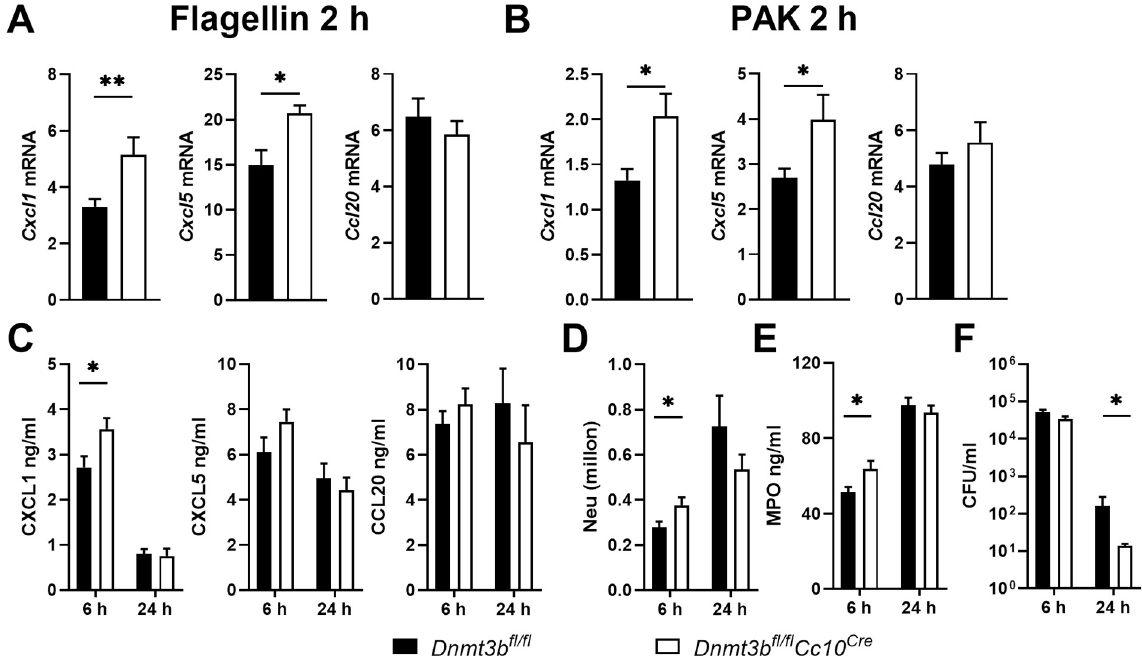
Fig 4. Bronchial epithelial deficiency of Dnmt3b promotes CXCL1 production by bronchial epithelial cells at the early phase of Pseudomonas pneumonia in vivo . Dnmt3b fl/fl Cc10 Cre and control Dnmt3b fl/fl mice received flagellin (1 μ g) purified from P . aeruginosa intranasally. Cxcl1 , Cxcl5 and Ccl20 mRNA expression in bronchial brushes collected at 2 hours (A). Dnmt3b fl/fl Cc10 Cre and control Dnmt3b fl/fl mice were infected with PAK (5 x 10 6 CFU) intranasally. Cxcl1 , Cxcl5 and Ccl20 mRNA expression in bronchial brushes collected at 2 hours (B). CXCL1, CXCL5 and CCL20 (C), neutrophil counts (D), MPO (E) and bacterial counts (F) in BALF were determined in BALF harvested after 6 or 24 hours. Data are presented as means ± SEM of 8 mice per group at each time point. � p < 0.05.